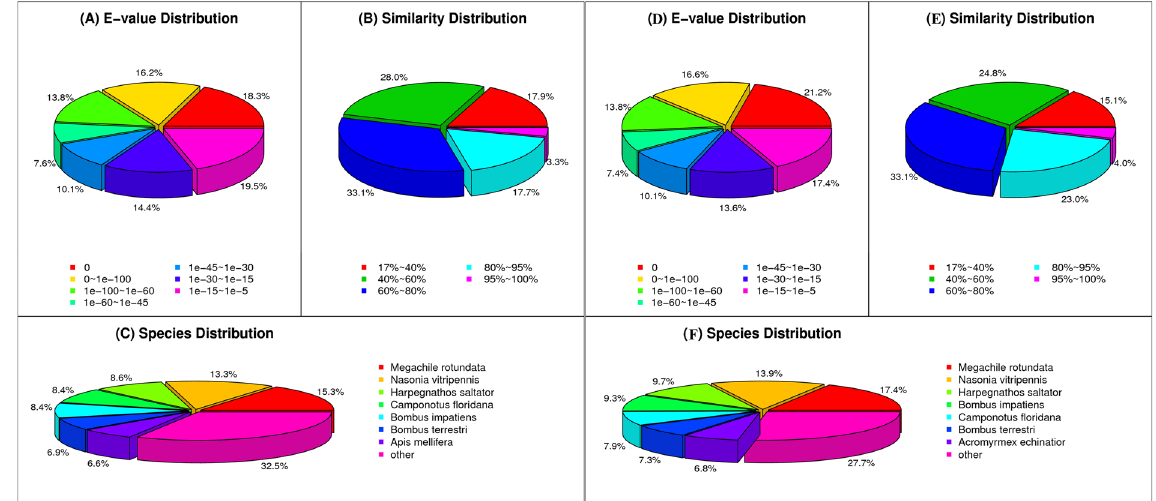
Figure 2. Characteristics of homology search of Illumina sequences against the nr database. ( A ) and ( D ): E-value distribution of BLAST hits for D . collaris all-transcripts and C . vestalis all-transcripts with a cut-off E-value of 1.0E − 5 . ( B ) and ( E ): Similarity distribution of the top BLAST hits for D . collaris all-transcripts and C . vestalis all-transcripts. ( C ) and ( F ): Species distribution is shown as a percentage of the total homologous sequences with an E-value of at least 1.0E − 5 in D . collaris all- transcripts and C . vestalis all-transcripts. We used the first hit of each sequence for